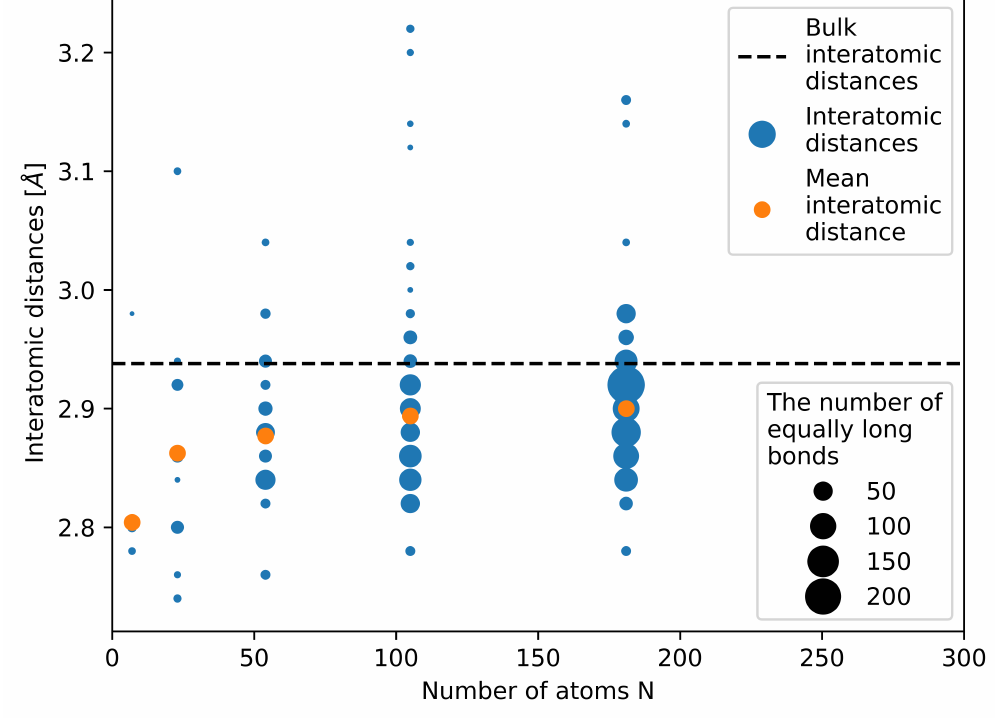
Figure 4. Computed bond lengths between pairs of nearest neighbors in the studied nanoclusters/nanoparticles. Blue symbols represent all inter-atomic distances in calculated nanoparticles, orange color marks the mean inter-atomic distances and the black dashed line shows the inter-atomic distance of bulk fcc structure of